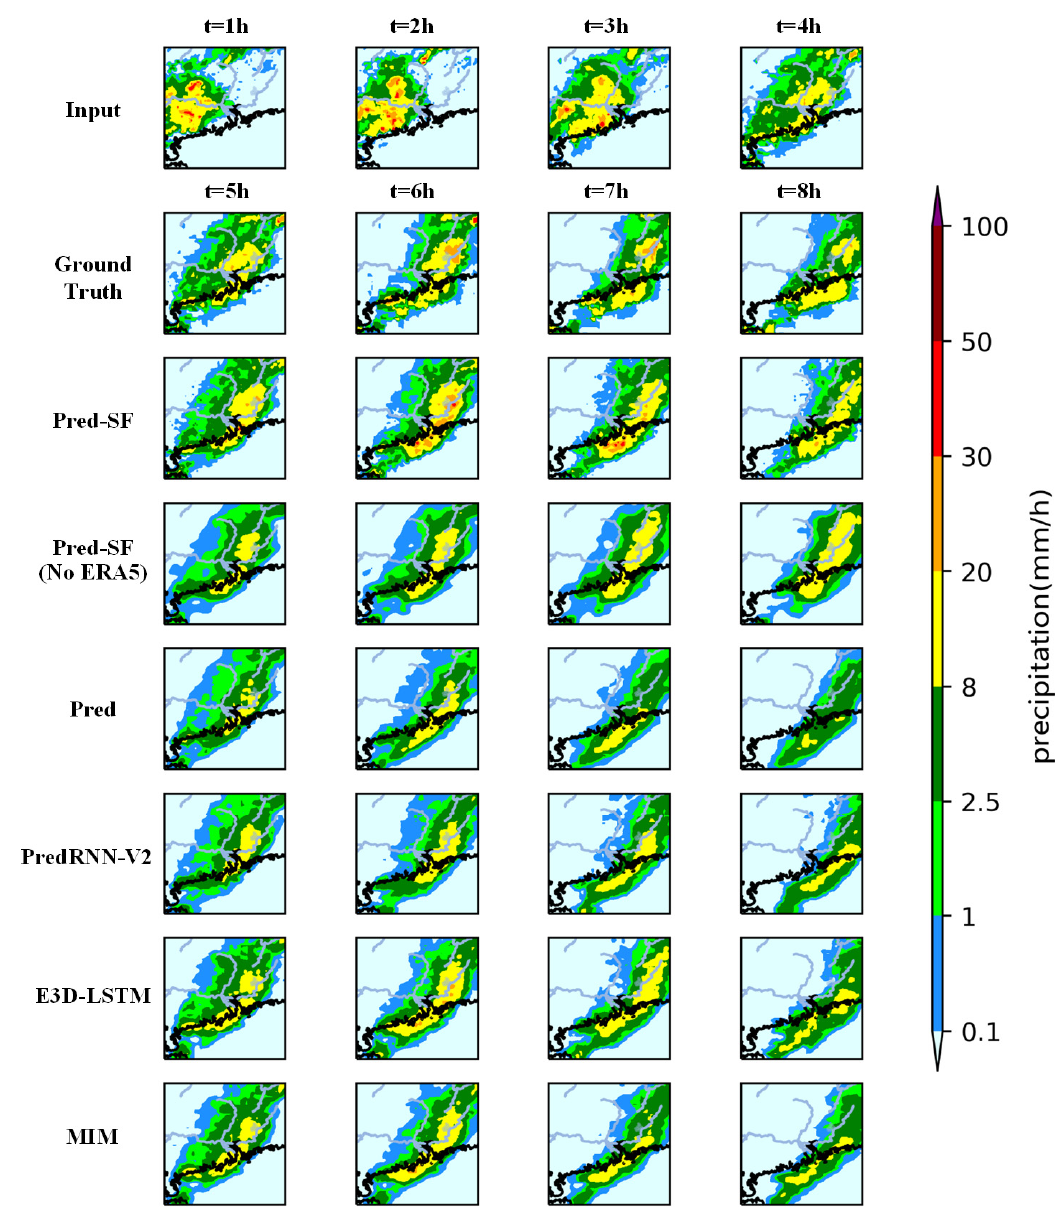
Figure 8. The precipitation prediction results of the six groups of models for 4 consecutive hours (4 time steps) are shown in the figure. Same as Figure